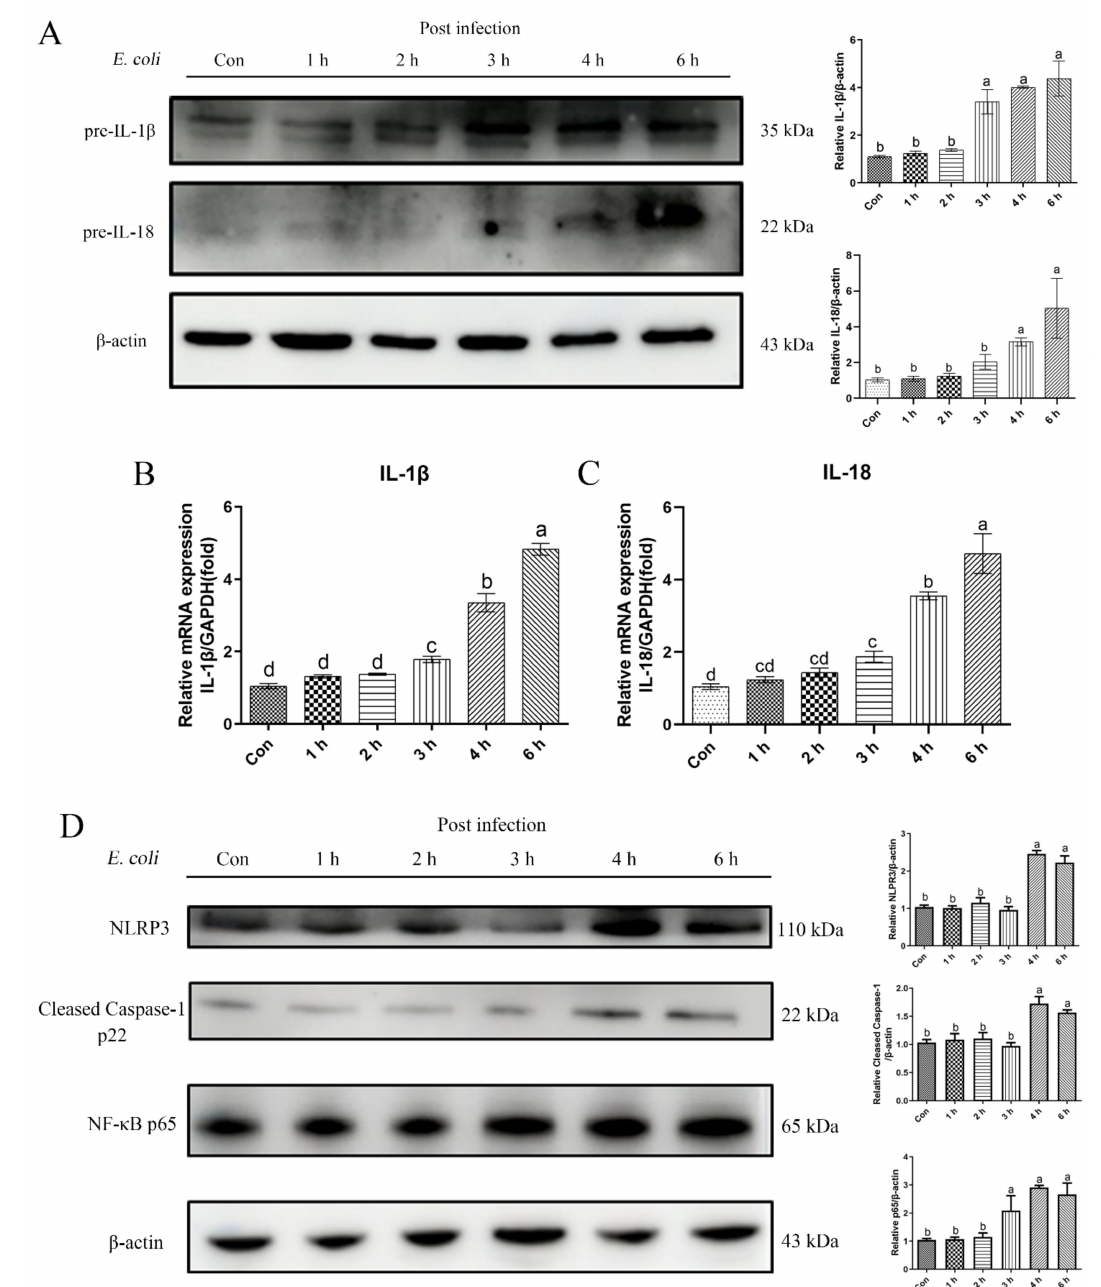
Figure 1. E. coli -induced inflammatory response in bEECs. Primary bEECs were infected with E. coli for 1 to 6 h, and cells were collected for protein and mRNA analyses. ( A ) Western blotting was used to analyze the pre-IL-1 β and pre-IL-18 levels in whole cell lysates. ( B ) Real-time quantitative PCR analysis of the expression of IL-1 β . ( C ) Quantification of IL-18 expression, with GAPDH as a control. ( D ) The levels of NLPR3, cleaved Caspase-1, and NF- κ B p65 proteins were analyzed by immunoblotting. The data are means ± SEM of three independent experiments. Bars with different letters indicate significant differences ( p <